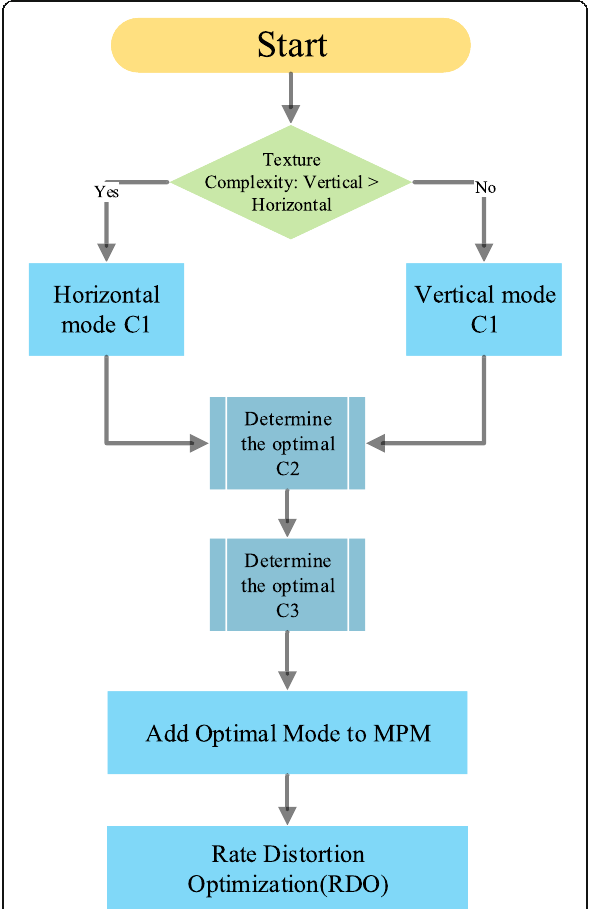
Fig. 13 Schematic of the proposed prediction mode decision algorithm based on texture direction